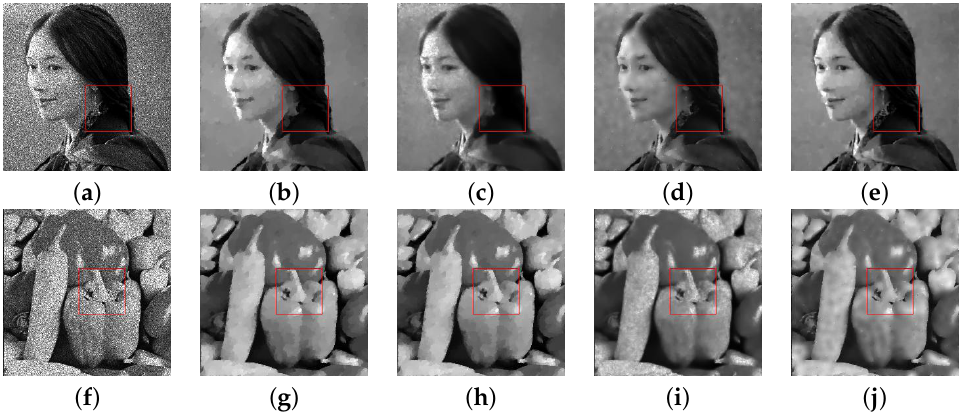
Figure 7. Recovery results of four algorithms on different images with the noise at L = 10: ( a ) De- graded. ( b ) CONVEX. ( c ) OGSTVD. ( d ) M-TGV. ( e ) NHOGSHL. ( f ) Degraded. ( g ) CONVEX.